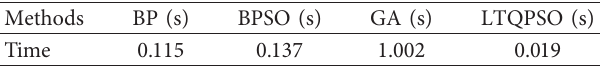
Figure 8: Comparison of fitness function values and iteration times of the four algorithms. Table 4: Comparison of the running time results of the four